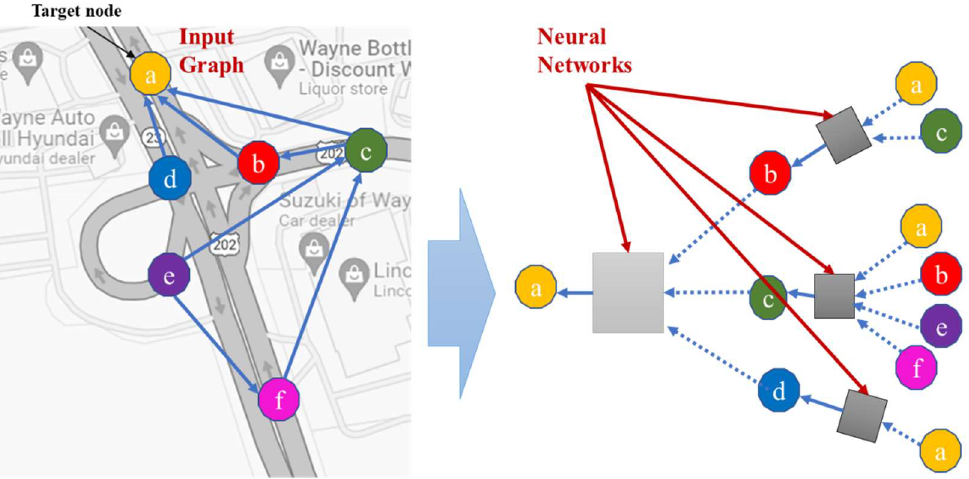
Figure 1. Sample GNN message-passing in a road network (a, b, c, d, e, and f are road network nodes with traffic data).